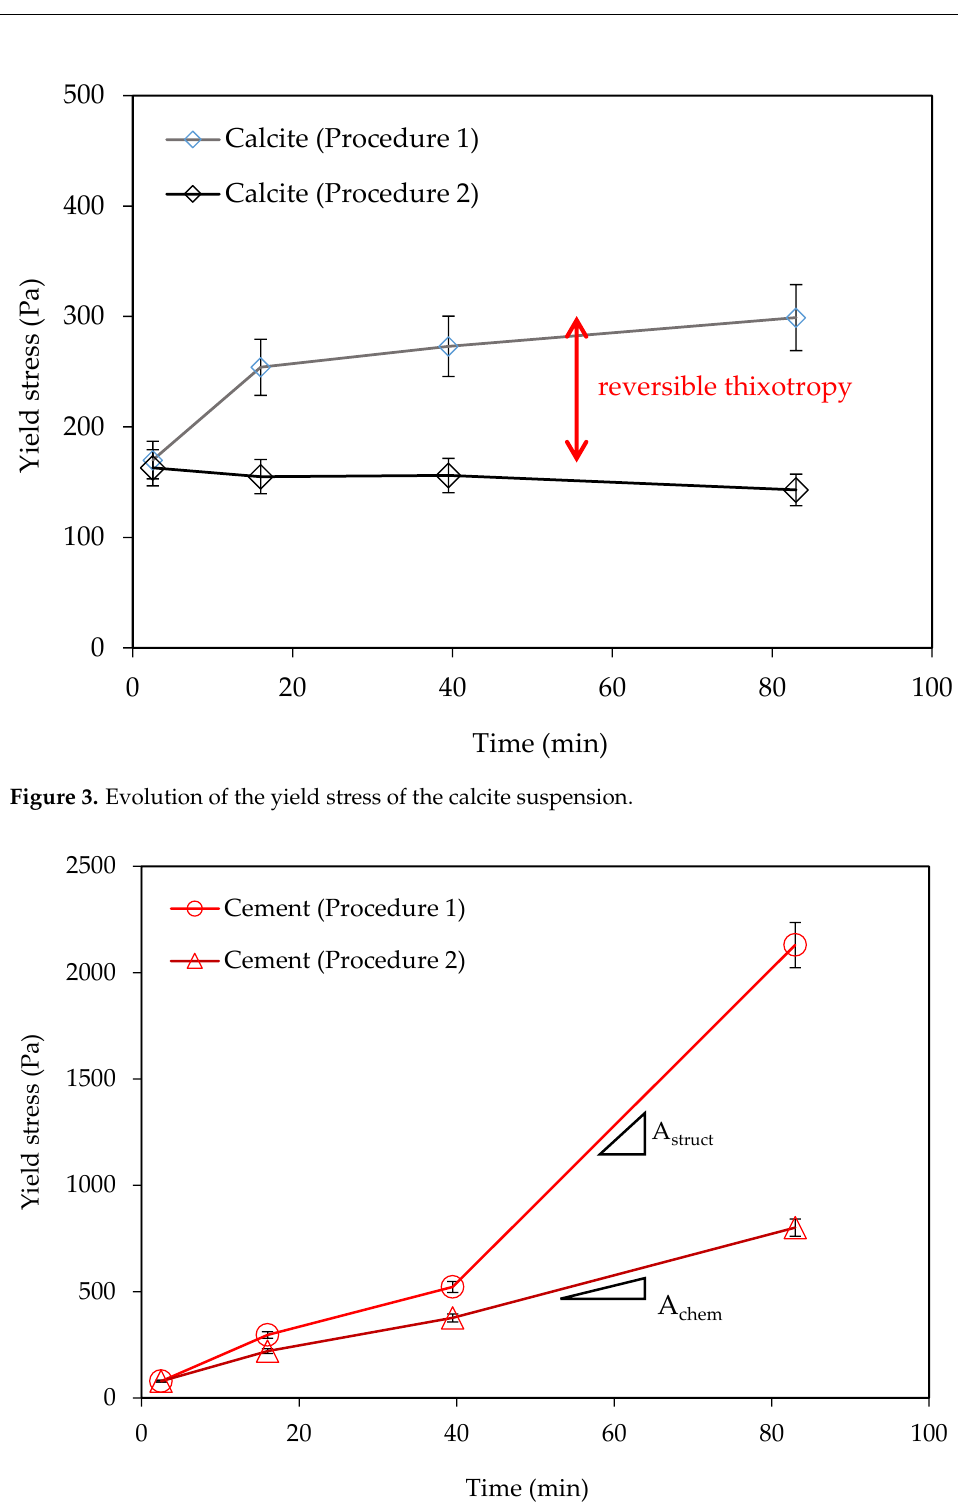
Figure 4. Evolution of the yield stress of the cement paste.